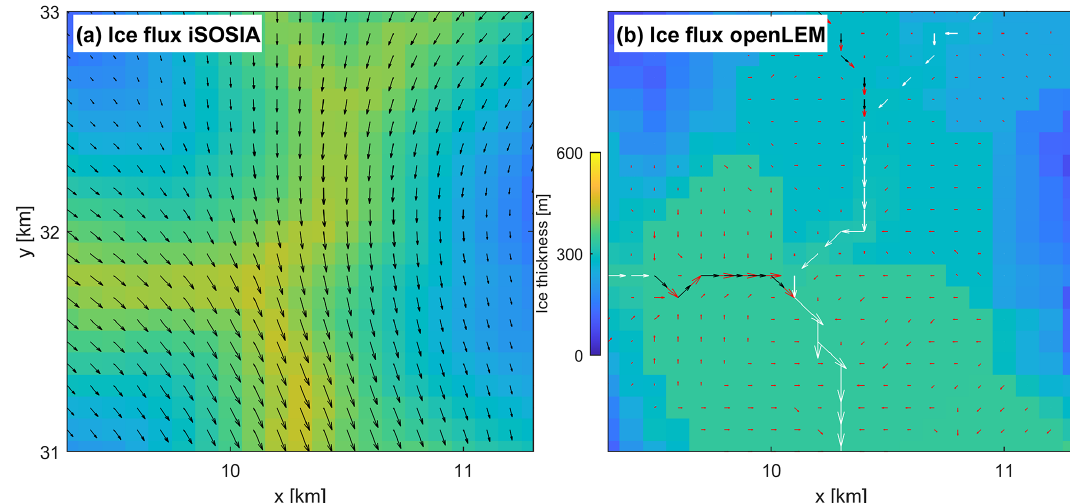
Figure 1. Illustration of the different approaches to describe the ice flow pattern. (a) Ice fluxes per unit width in iSOSIA. (b) Ice fluxes in OpenLEM. Black and white arrows correspond to the ice flux obtained from the mass balance. Fluxes along the cardinal flow line are emphasized by white arrows. Red arrows are the artificially increased fluxes in a swath around the cardinal flow line, which are finally used in Eq. (7) for computing the erosion rate. The arrows are scaled arbitrarily in both parts. The domain corresponds to the red square in Fig. 2a and